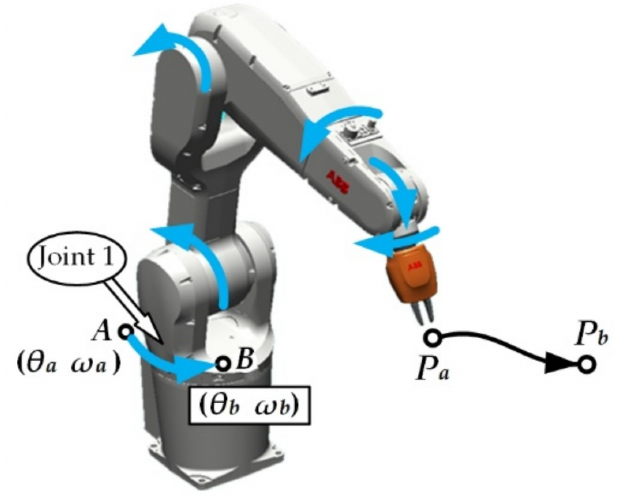
Figure 1. Point-to-Point